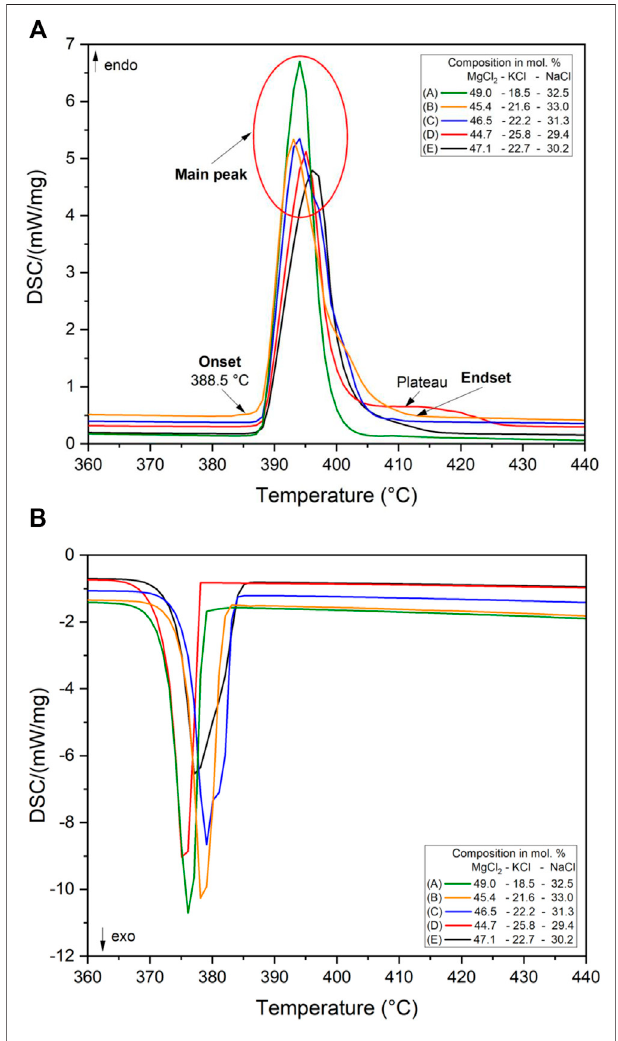
FIGURE 5 | DSC heating (A) and solidi fi cation (B) curves for the ternary MgCl 2 – KCl – NaCl mixtures with the minimum melting temperature composition reported and listed